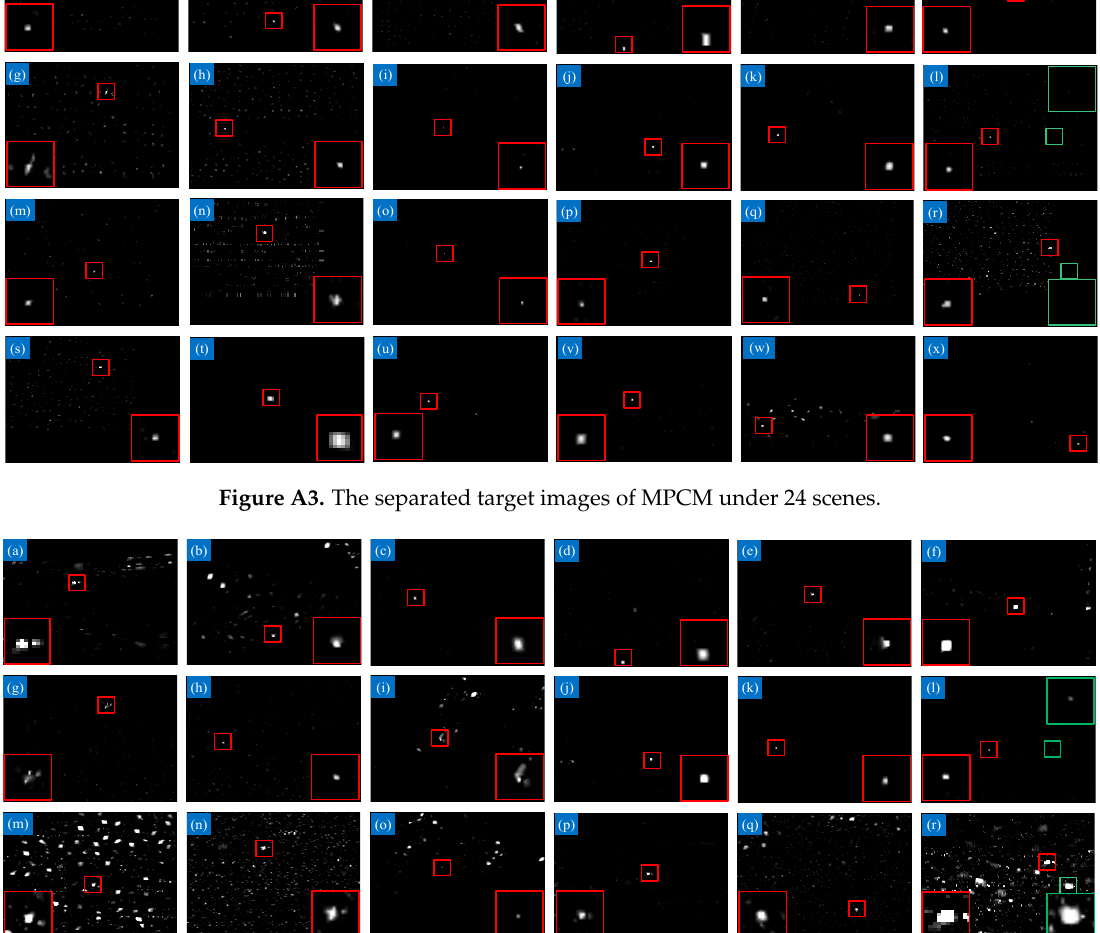
Figure A2. The separated target images of LoG under 24 scenes.